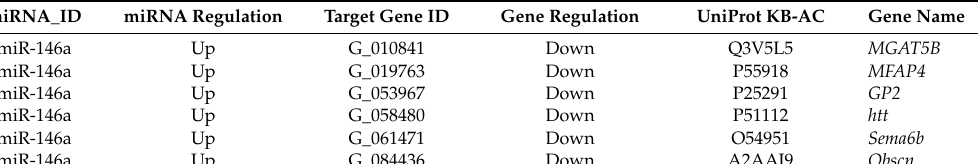
Table 5. Interaction analysis of miR-146a and its target DE genes.